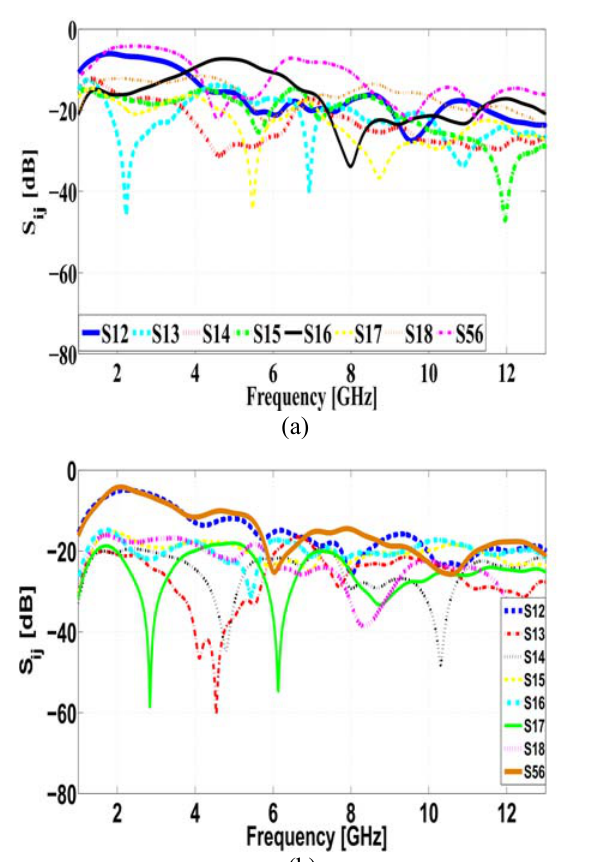
(b) FIGURE.5 Simulated mutual coupling comparison, (a) before ports shift utilization, (b) after ports shift